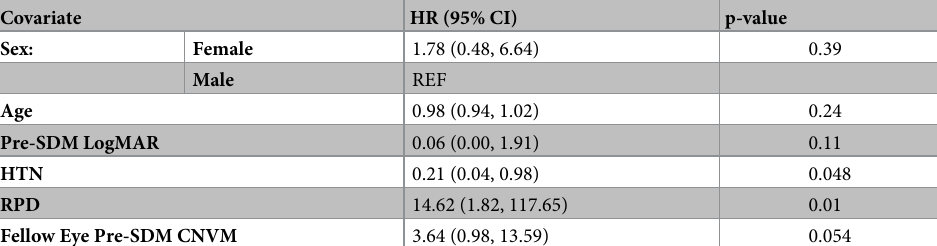
Table 3. Univariate Cox regression models using sandwich estimator to account for inter-eye correlation.